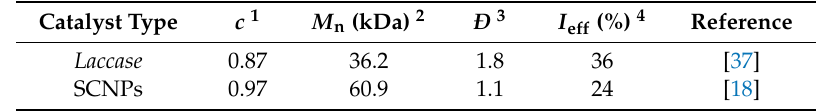
Comparison of Laccase enzyme and single-chain nanoparticles (SCNPs) as artificial metalloenzymes for the synthesis of high molecular weight polyOEGMA via controlled/living radical polymerization in water.